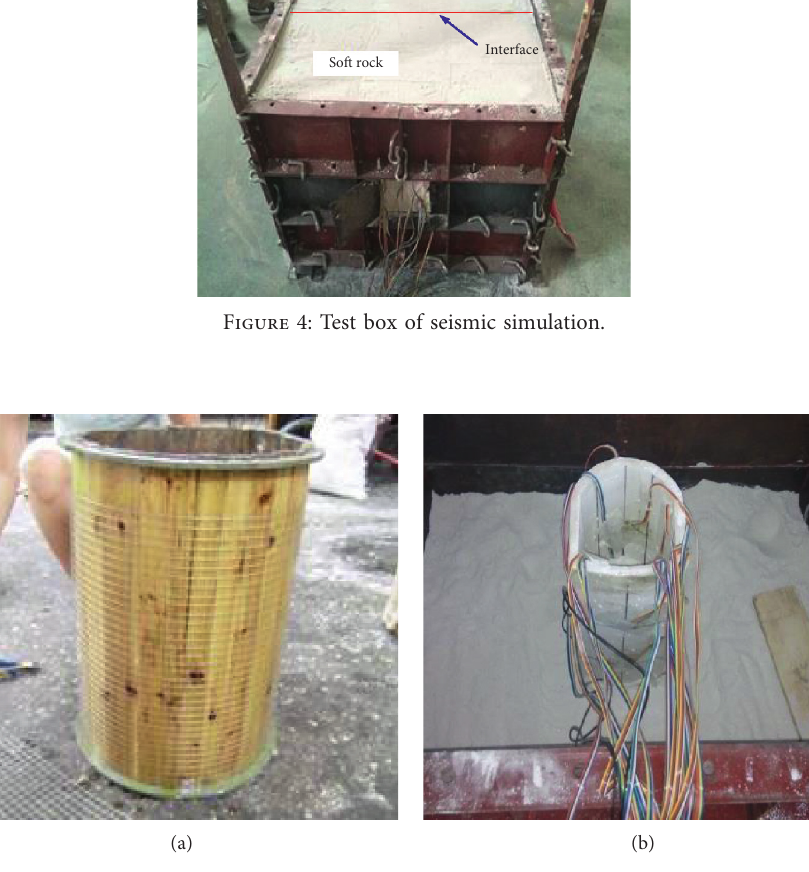
Figure 5: Model of second lining. (a) Steel wire. (b) The gypsum of second lining. Table 4: Test results and mixture ratio of similar materials of surrounding rock.